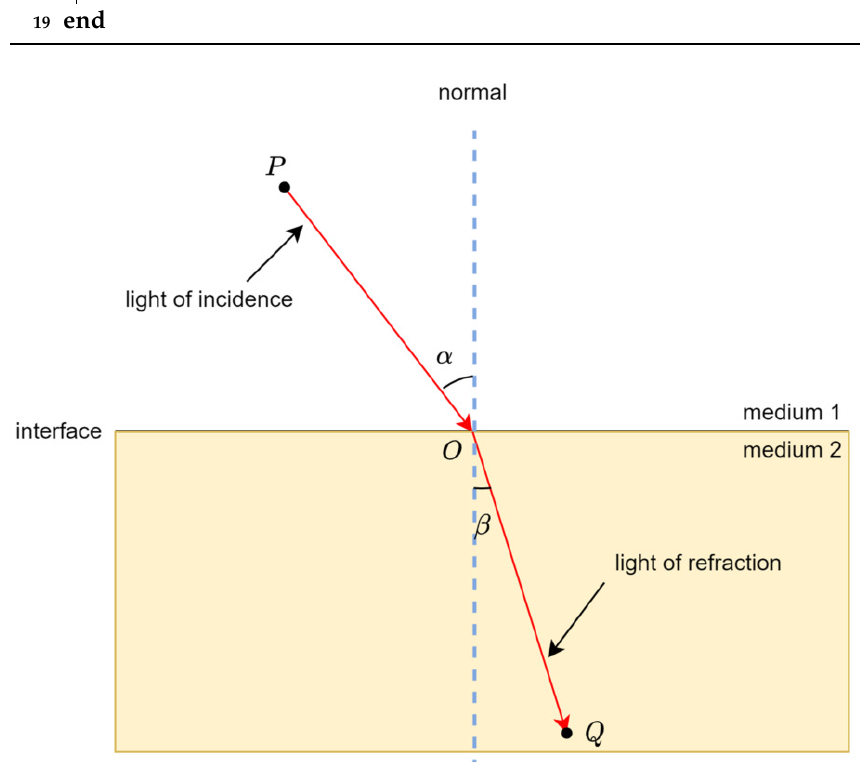
Figure 1. Principle of light